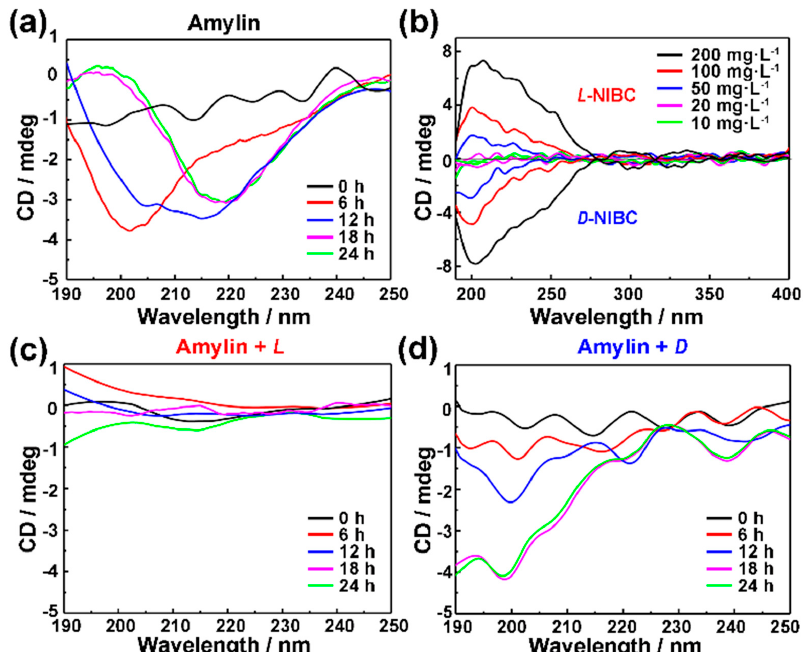
Figure 4. Time-dependent CD spectra profiles of 10 μ M amylin co-incubated without ( a ) / with 20 mg·L − 1 L -NIBC-AuNPs ( c ) and D -NIBC-AuNPs ( d ) in ultrapure water at 37 °C. The colors of the curves represented different time points of incubation period, black: 0, red: 6th h, blue: 12th h, purple: 18th and green: 24th h. ( b ) The CD spectra of L ( D )-NIBC-AuNPs with different concentration.